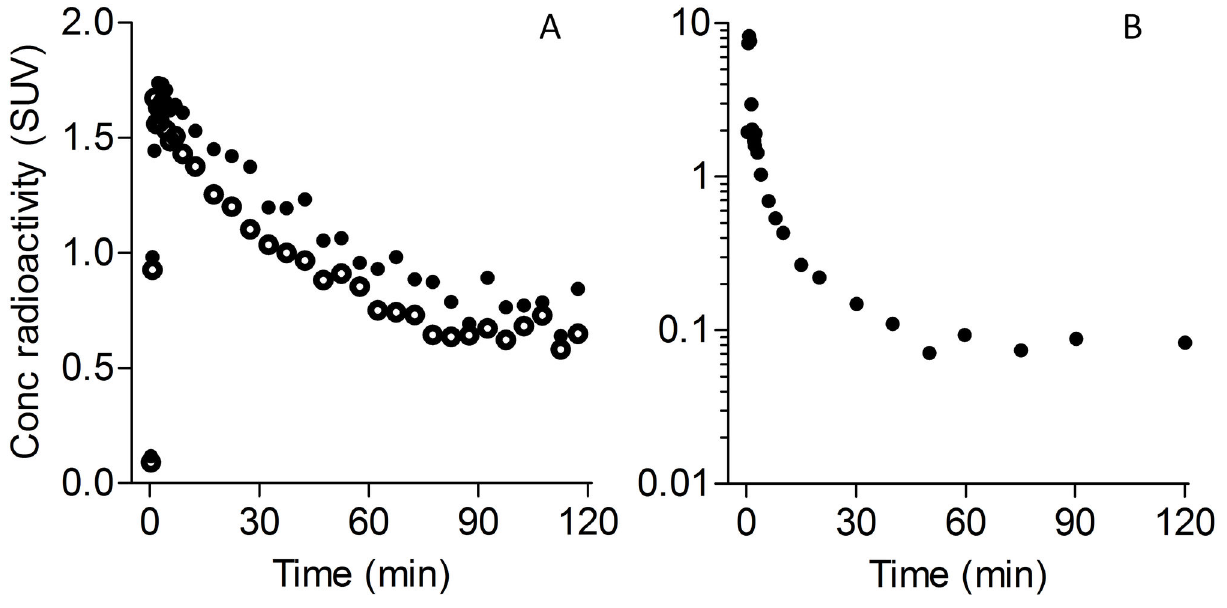
Figure 1. Positron emission tomography measurement of 11 C-PBR28 binding. In the first six scans including scan 1 of patient 1 shown in Figure 1, 11 C-PBR28 binding was measured as total distribution volume, V , using Logan plot [12] based on radioactivity T measured by the PET scanner (A, closed circles: perilesional edema in left basal ganglia, open circles: contralateral side with normal MRI) and 11 C-PBR28 concentration in arterial plasma measured with radio-high performance liquid chromatography (B). Brain activity decreased to half of the peak in about 60 min indicating that none of the participants including this patient was a low affinity binder [14] to 11 C-PBR28. Both the analyses using only area under the curve of brain radioactivity (A) and that using both brain (A) and arterial blood data (B) gave the same increase of 14% in 11 C-PBR28 binding indicating that arterial blood sampling was